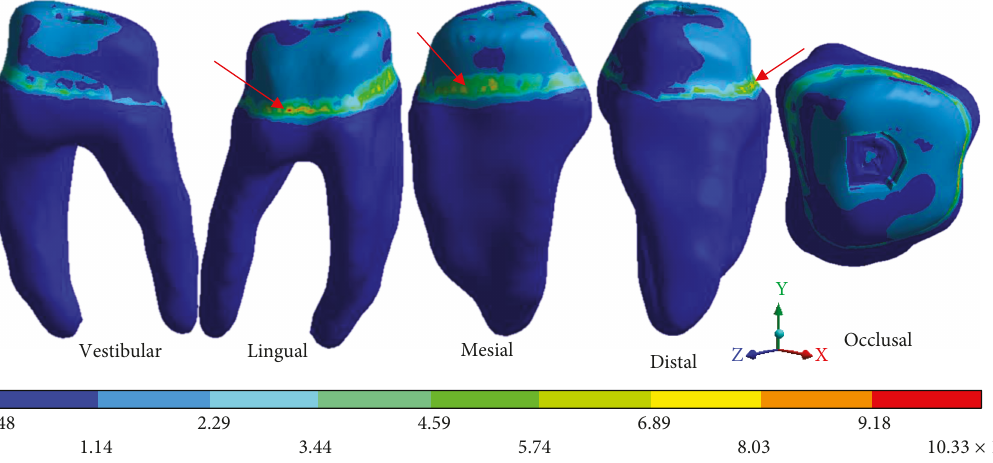
Figure 13: 2nd degree caries : von Mises stresses in dentin.